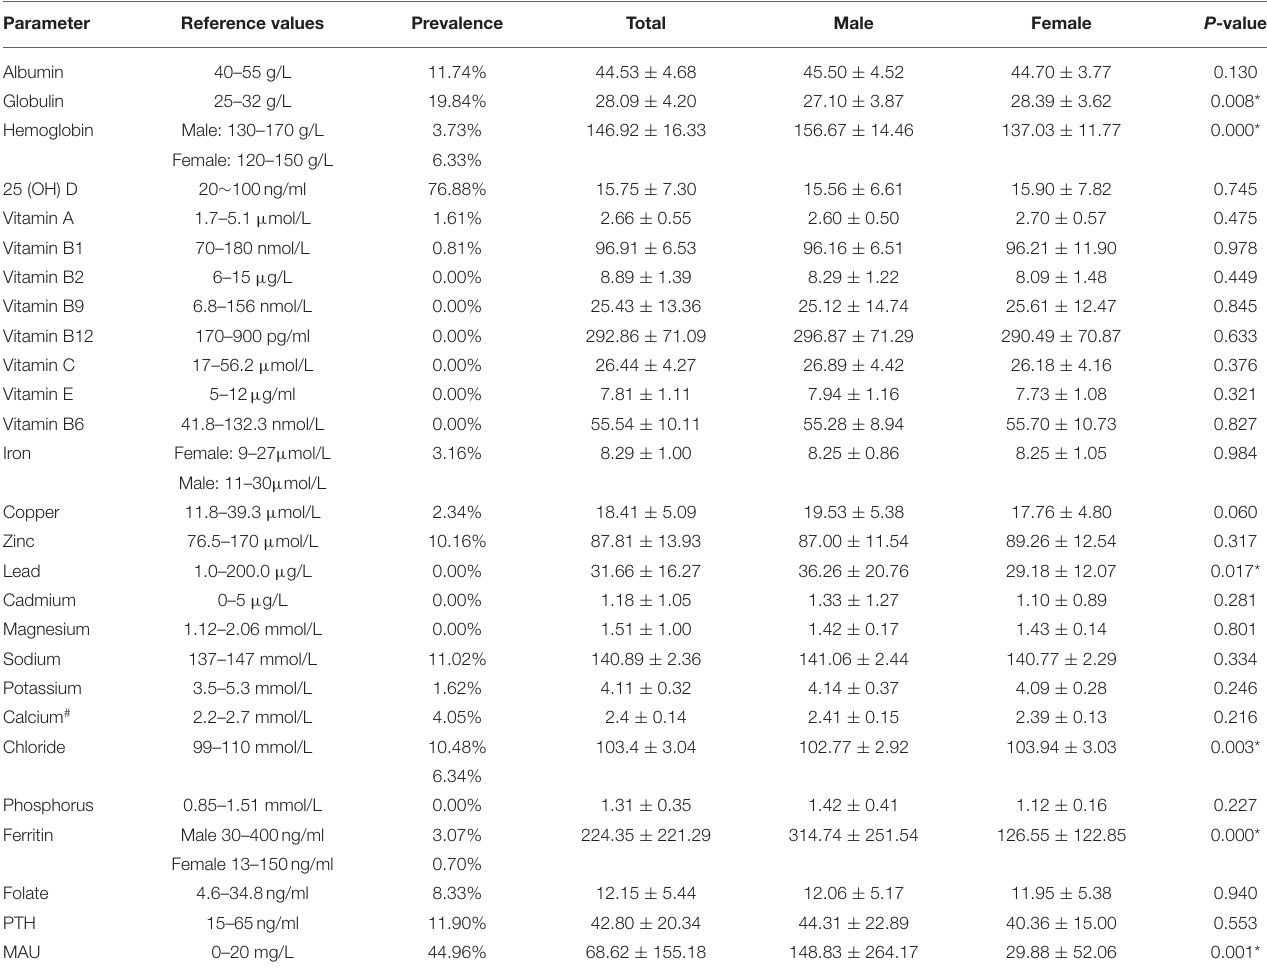
TABLE 2 | Biochemical parameters and comparison between male and female prior to bariatric surgery. Parameter